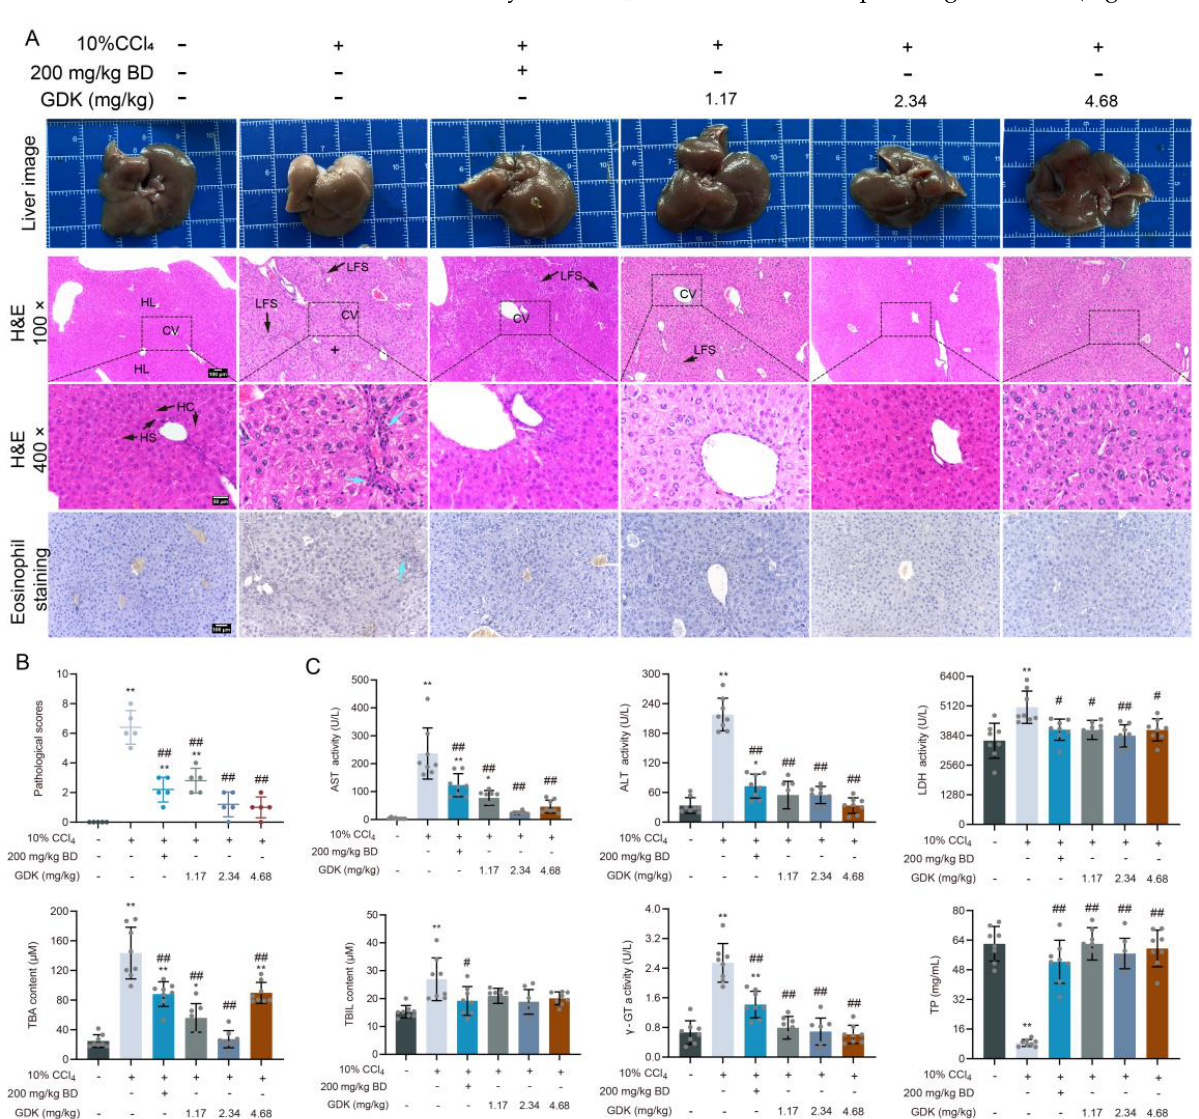
Figure 2. GDK improves hepatic function and structure in CCl 4 -induced chronic liver injury mice. ( A ) Representative images of the liver; hematoxylin and eosin (H&E)- and eosinophil-stained images of liver sections in indicated mice. Scar bar, 100 µ m (100 × and 200 × ), 50 µ m (400 × ). n = 5 per group. LFS: Long fiber spacing; HL: Hepatic lobule; HS: Hepatic sinusoid; HC: Hepatic cord. Blue arrow: inflammatory cell infiltration. ( B ) Pathological scores. ( C ) Serum ALT, AST, LDH, TBIL, TBA, γ -GT, and TP levels in indicated mice. n = 8 samples per group. * p < 0.05, ** p < 0.01, # p < 0.05, and ## p < 0.01.